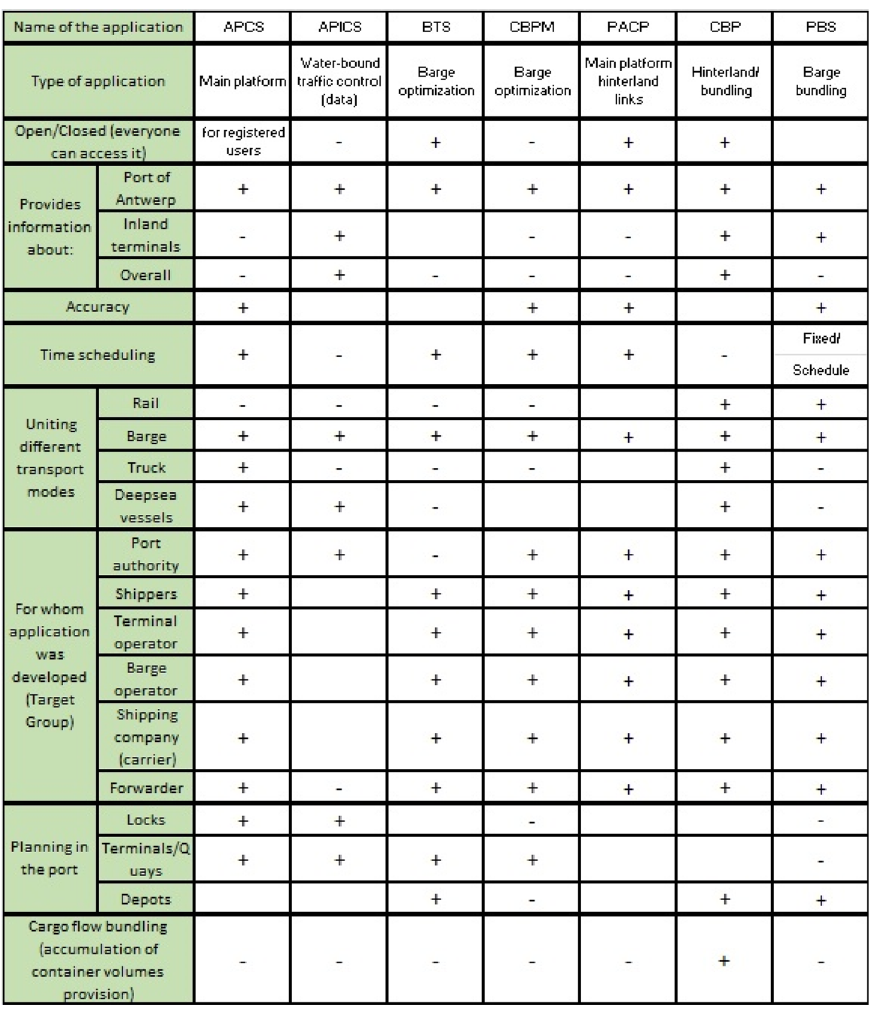
Table 1 Overview of the Different Port-Barge Related